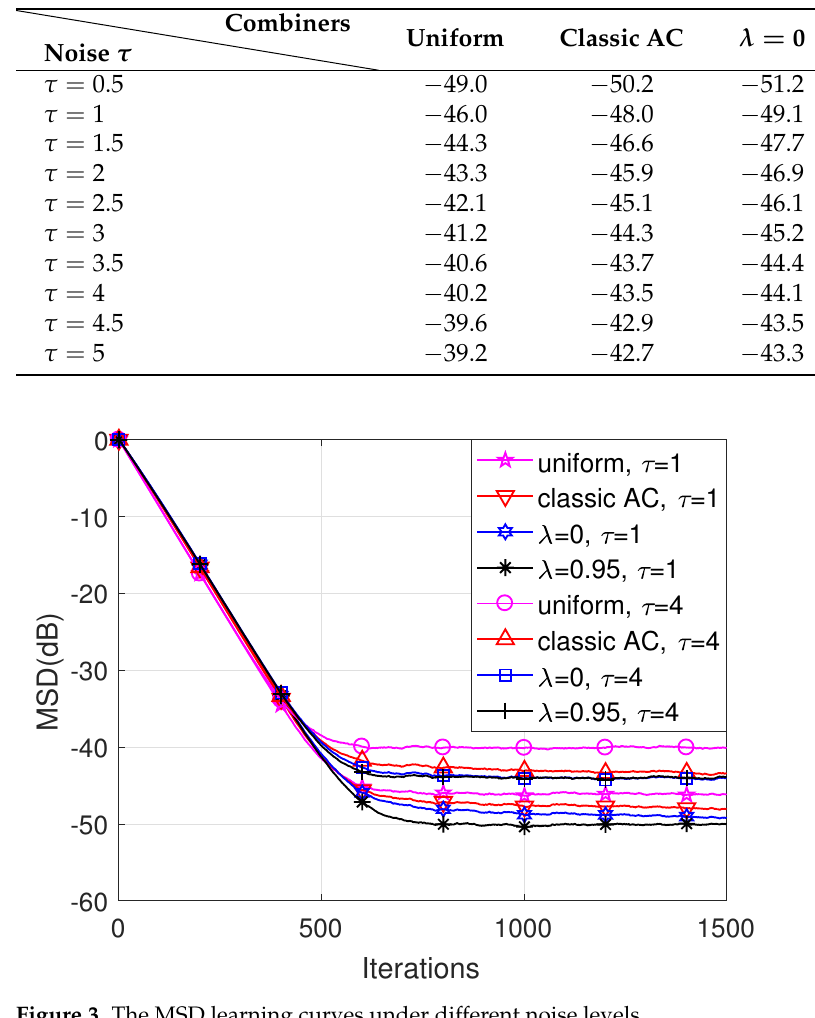
Figure 3. The MSD learning curves under different noise